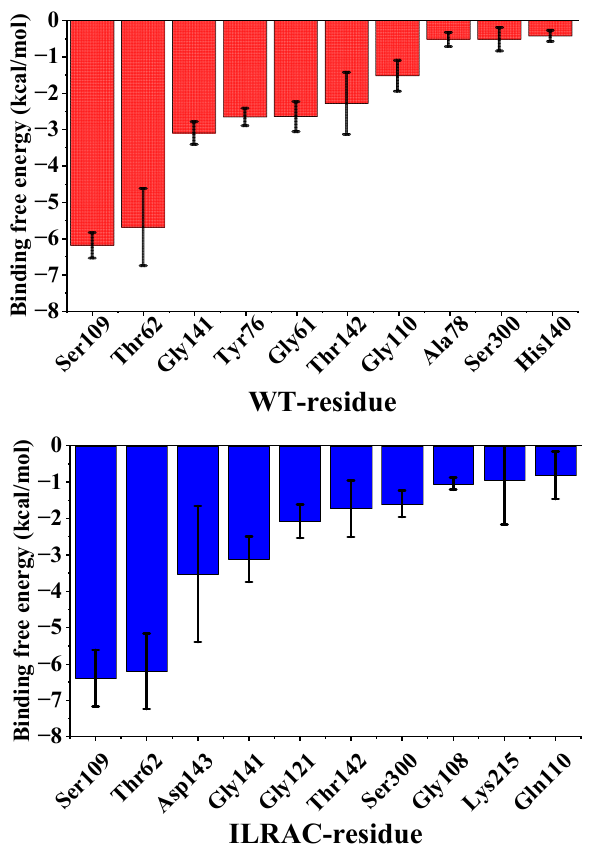
Figure 5. The top 10 residues that contribute to protein and substrate binding.